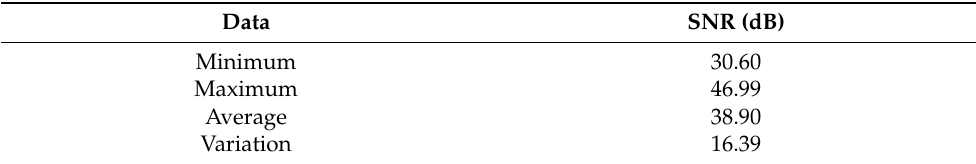
Table 3. Statistical Data of the SNR—2MAV-PLL.